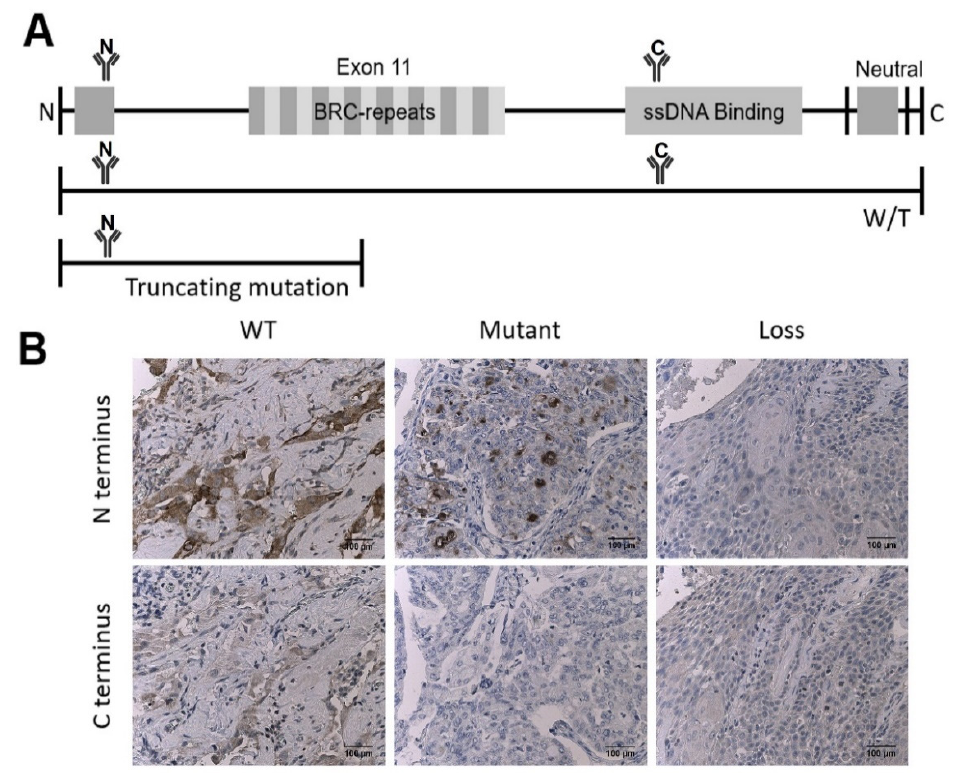
Figure 1. Schematic showing immunohistochemical staining of BRCA2 protein using two-antibody strategy. ( A ) A full-length gene model, a full-length wild-type protein model bound by both the N- terminal and C-terminal antibodies, and a truncated protein bound by only the N-terminal antibody (loss protein model not shown as it is not expressed and therefore cannot be bound by either antibody). ( B ) Representative microscopy images of sequenced ovarian cases with known genomic status, magnification 100 × , scale bar = 100 µ m. Wild-type (WT) expression pattern with staining of strong intensity with N-terminal antibody (top left) and moderate intensity with C-terminal antibody (bottom left) in some of the tumor cell nuclei; aberrant expression with moderate staining intensity with N-terminal antibody (top middle) and poor staining intensity with C-terminal antibody (bottom middle) in the verified case with truncating mutation (Mutant); poor staining intensity of both N-terminal (top right) and C-terminal (bottom right) antibodies in the verified case with BRCA2 loss (Loss).